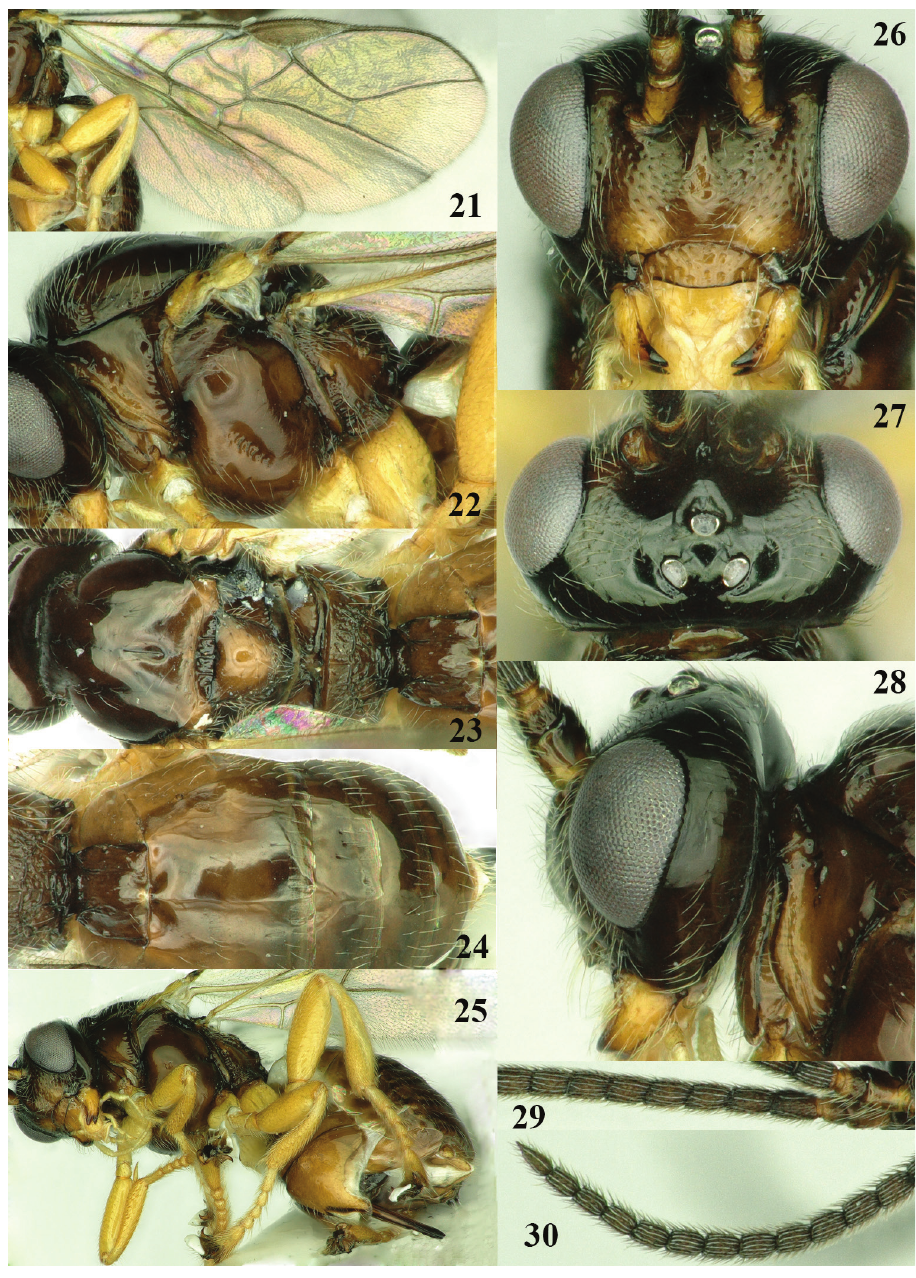
soma and first metasomal tergite dorsal 24 metasoma dorsal 25 legs and hypopygium antero-ventral 26 head anterior 27 head dorsal 28 head lateral 29 basal antennal segments 30 apical antennal